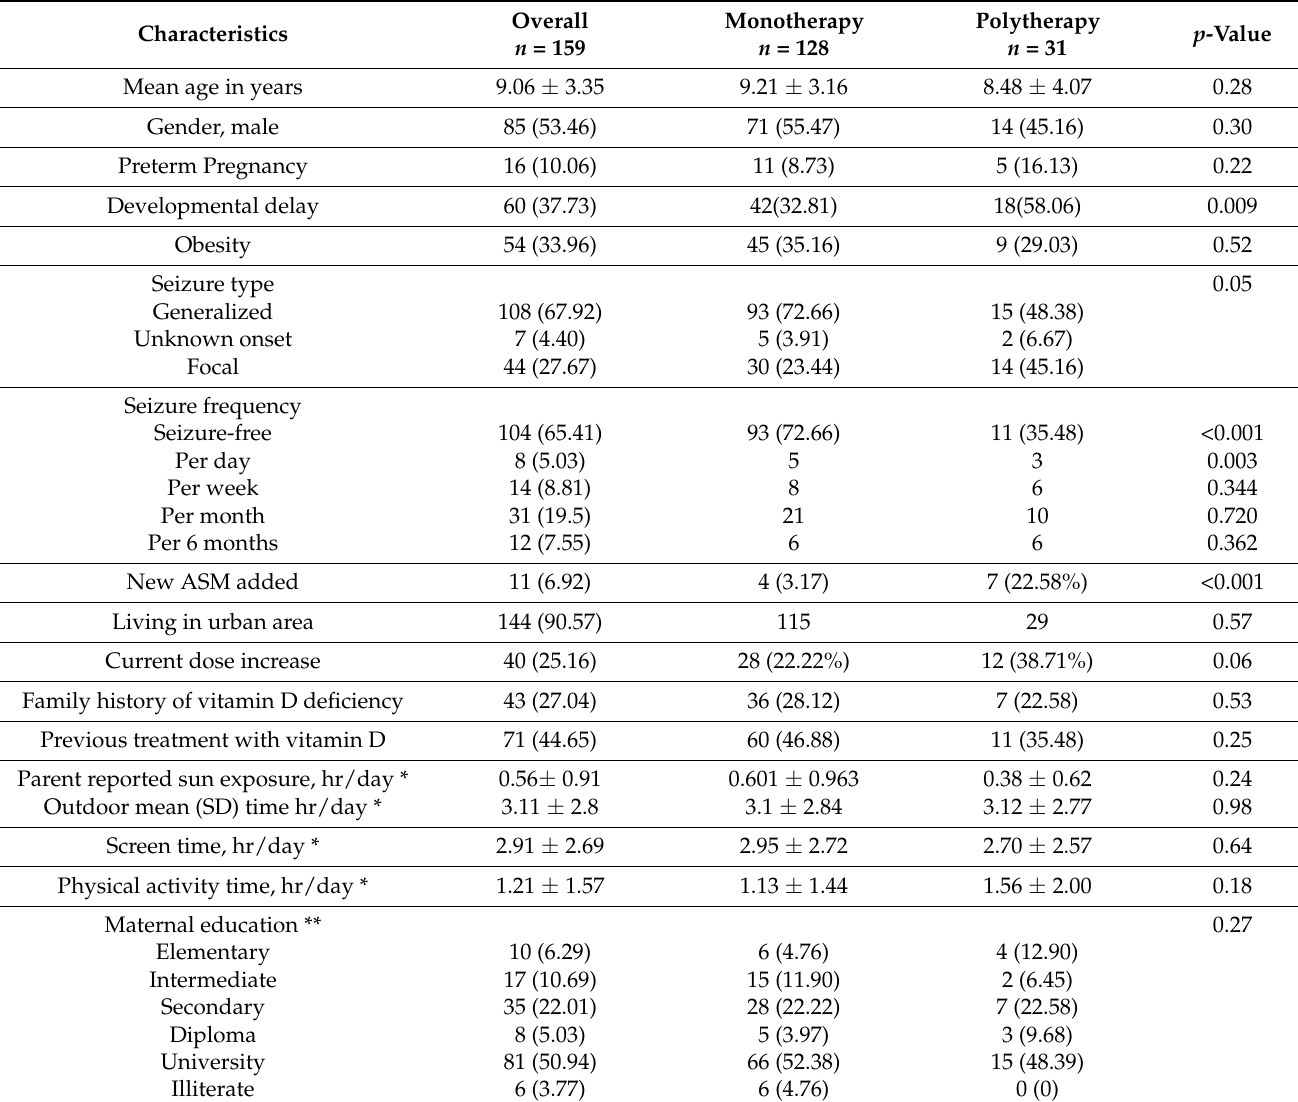
Table 1. Baseline characteristics of the